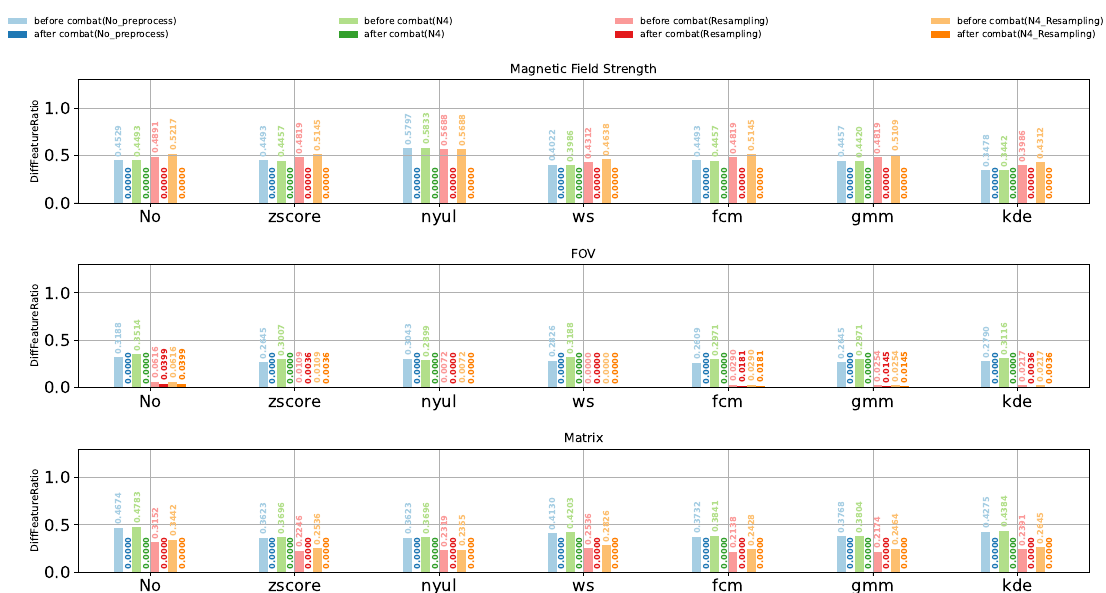
Figure 3. Impact of different preprocessing and harmonization methods for healthy volunteer data.